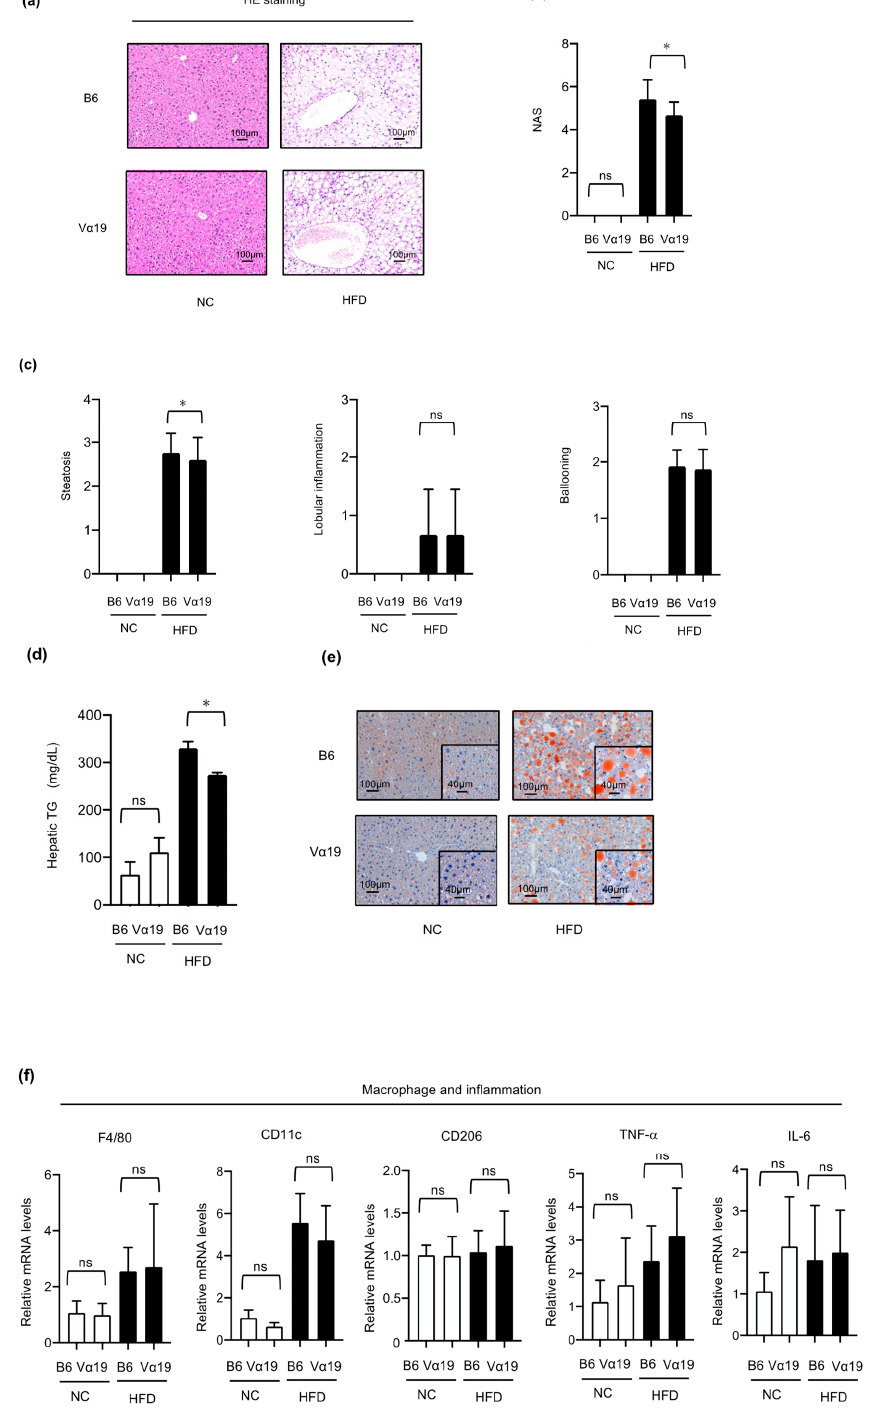
Figure 2. Non-alcoholic fatty liver disease activity score and lipid accumulation in the liver decreased in V α 19 mice fed a high-fat diet. ( a ) Liver sections stained with hematoxylin and eosin (HE) from V α 19 mice (V α 19) and C57BL/6 mice (B6) fed normal chow (NC) and a high-fat diet (HFD) at 27 weeks of age. Representative images are shown. Scale bar:100 µ m. ( b , c ) Non-alcoholic fatty liver disease activity score (NAS) ( b ) and its components ( c ) were determined by examining 18 liver sections stained with HE. ( d ) Quantification of hepatic triglycerides. ( e ) Liver sections stained with Sudan III. ( f ) mRNA levels of macrophage- and inflammation-related genes. Data on each mRNA were normalized according to the 36B4 mRNA level. Results are shown as the mean ± SD for 4 to 6 mice per group. * p < 0.05, ns, not statistically significant.